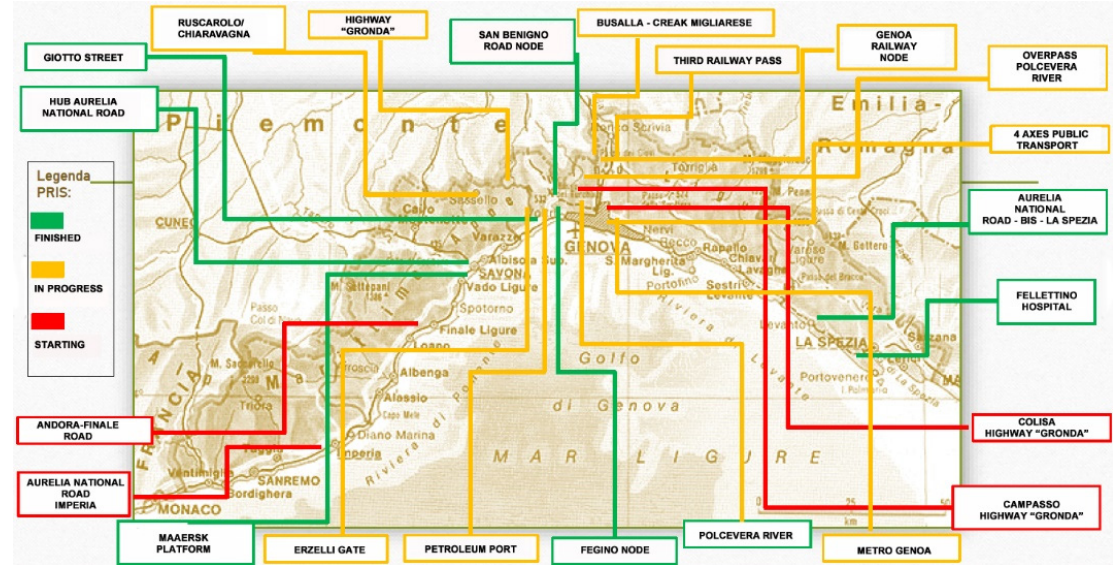
Figure 1. Infrastructure projects in the Liguria Region (source: Liguria Region).